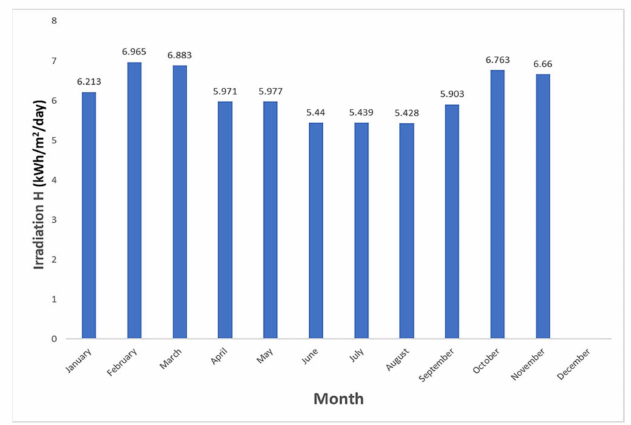
Figure 7. Monthly average of daily irradiation on site for the year 2020.